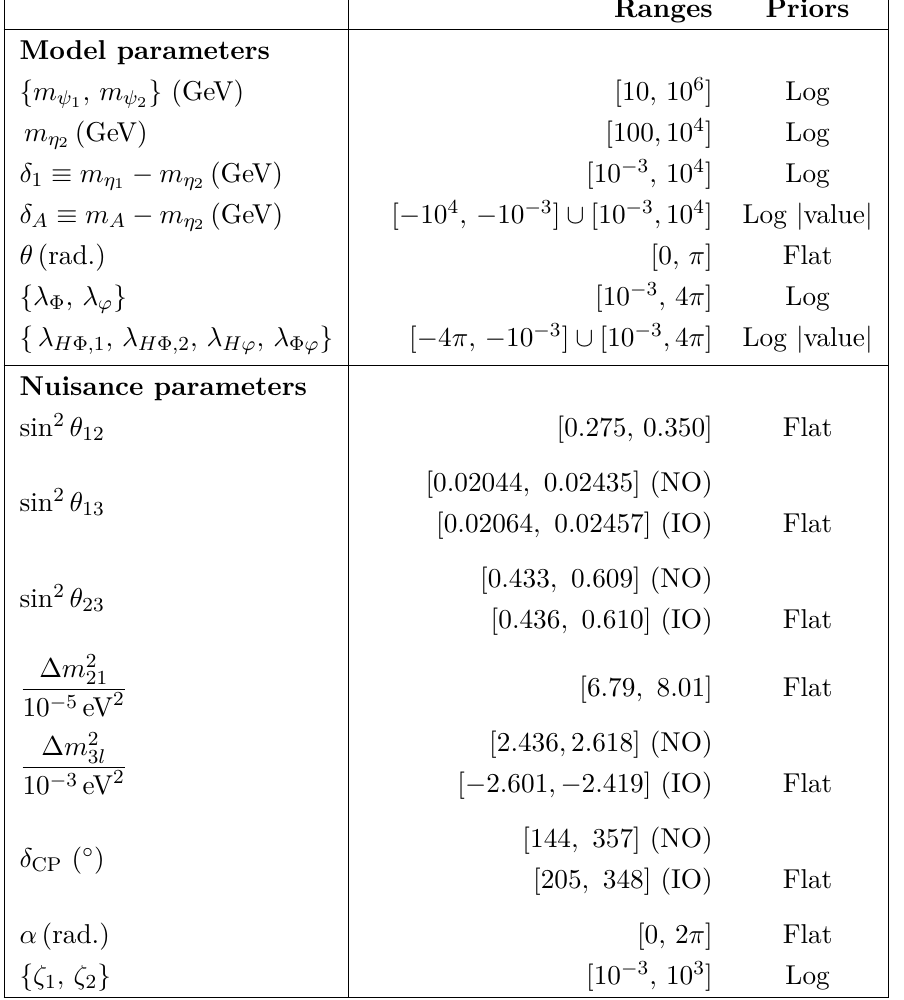
Table 3 . Ranges and priors for 21 (12 free + 9 nuisance) model parameters. The parameters { ζ 1 , ζ 2 } belong to the R matrix of the Casas-Ibarra parametrization [36] (see appendix B), whereas α is the Majorana phase in the PMNS matrix. The terms NO (IO) refer to Normal